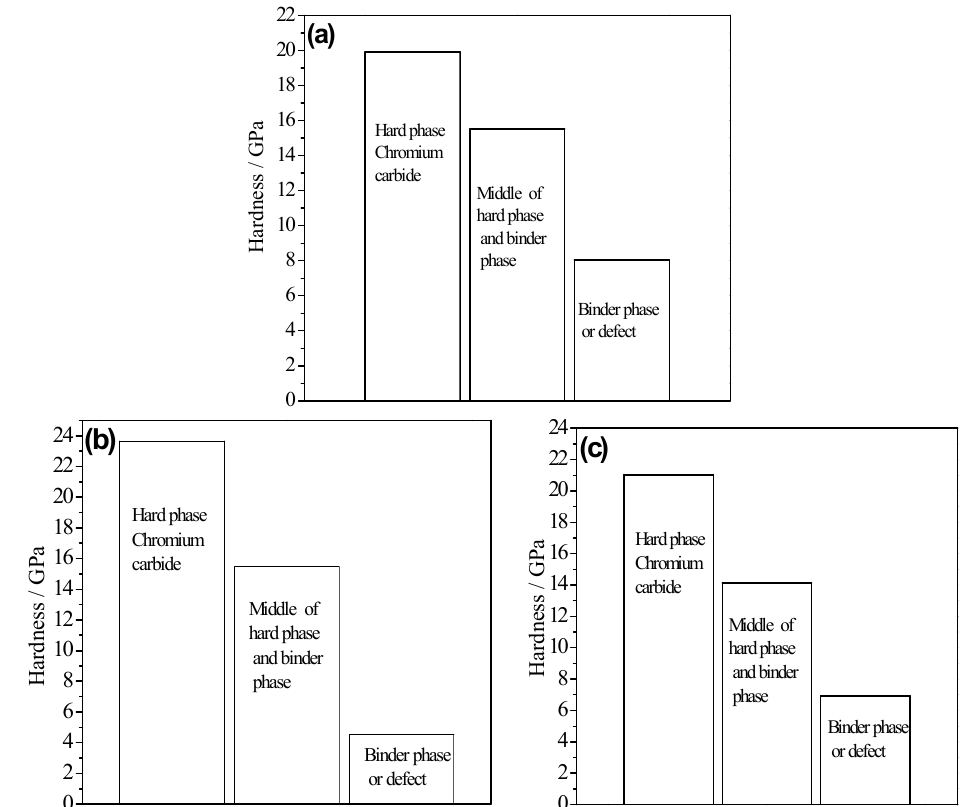
Figure 5. The classification of nano-indentation readings on coatings ( a ) coating- A , ( b ) coating- B , ( c ) coating- C .